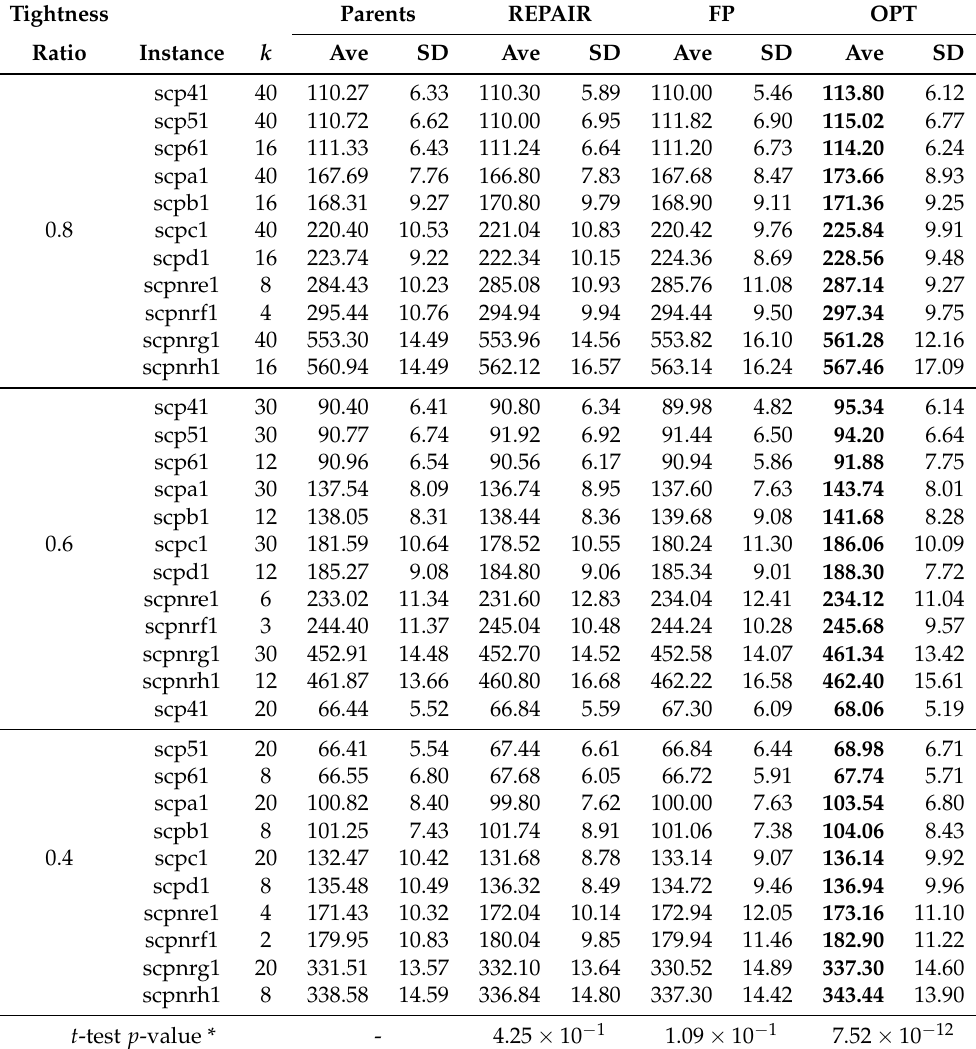
Table 2. Effect of normalization on a single crossover, after the REPAIR, FP, and OPT procedures. Tightness Parents REPAIR FP OPT Ratio